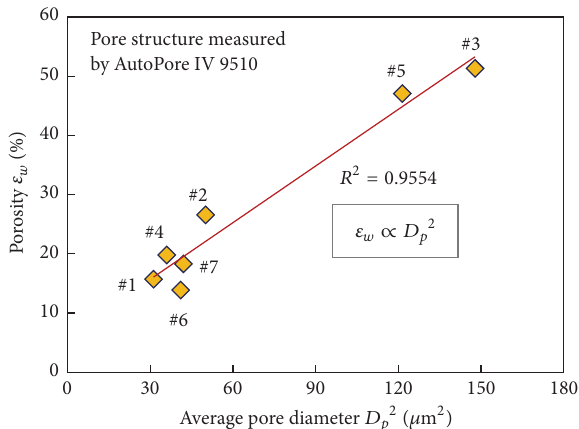
Figure 10: The relationship between ( d Δ𝑃/ d 𝑡) initial and 𝐹 󸀠 DB after revising parameter 𝐹 DB